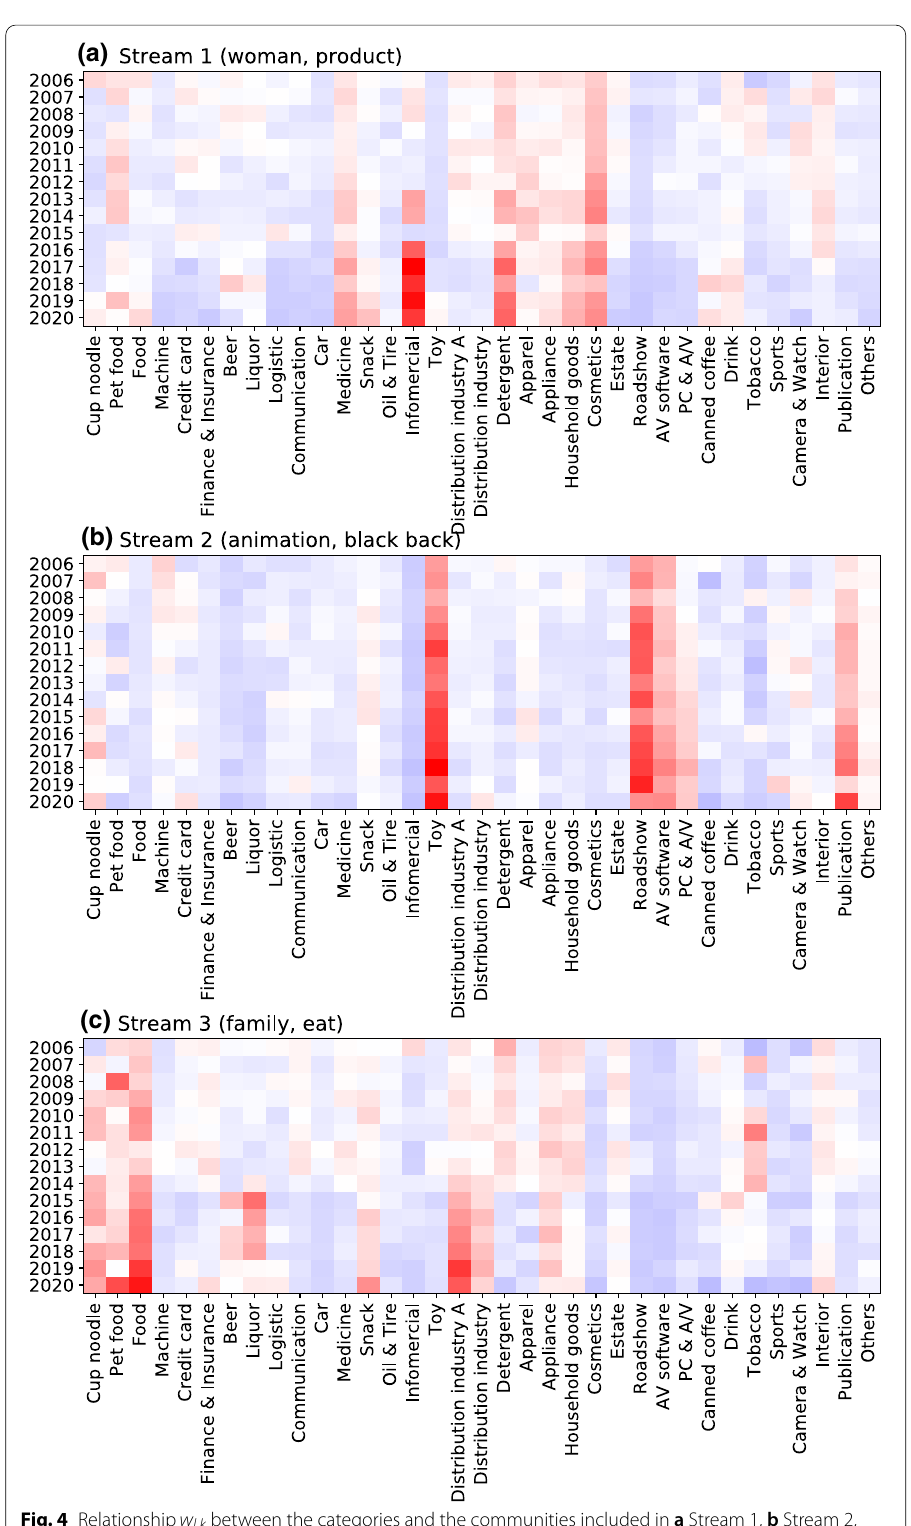
Fig. 4 Relationship w l , k between the categories and the communities included in a Stream 1, b Stream 2, and c Stream 3, for each